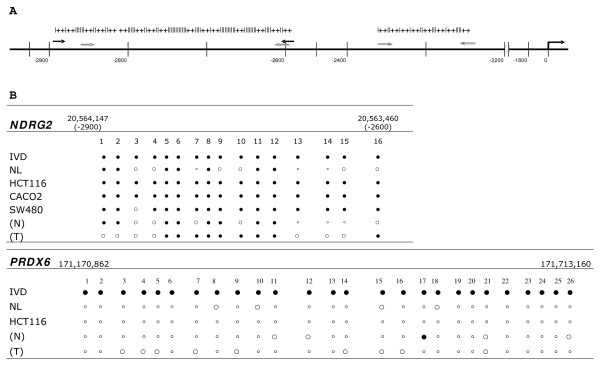
CpG islands present in putative promoter regions of the two genes of interest. A. Promoter structure of NDRG2 gene (the sequence are shown in Additional file 2). The black arrows correspond to NDRG2 primers for BSA assay, the grey arrows correspond to NDRG2_M_2 and NDRG2_M primers for MSP assays. B. CpG islands present in NDRG2 (numbered from 1 to 16) and PRDX6 (numbered from 1 to 26) genes obtained by MethPrimer software. Methylation status of CpG sites in vitro methylated DNA (IVD), normal lymphocytes (NL), three colon cancer cell lines, and in normal (N) and tumor (T) tissue of one patient with colorectal cancer. Methylated and unmethylated cytosine residues are indicated with filled and small circles while open circles denote partially methylated sites.